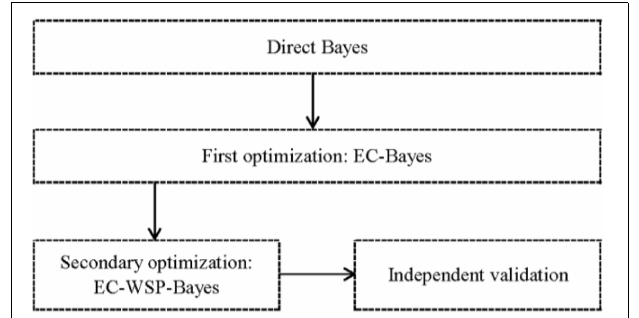
FIGURE 1 | Schematic diagram of modeling framework.